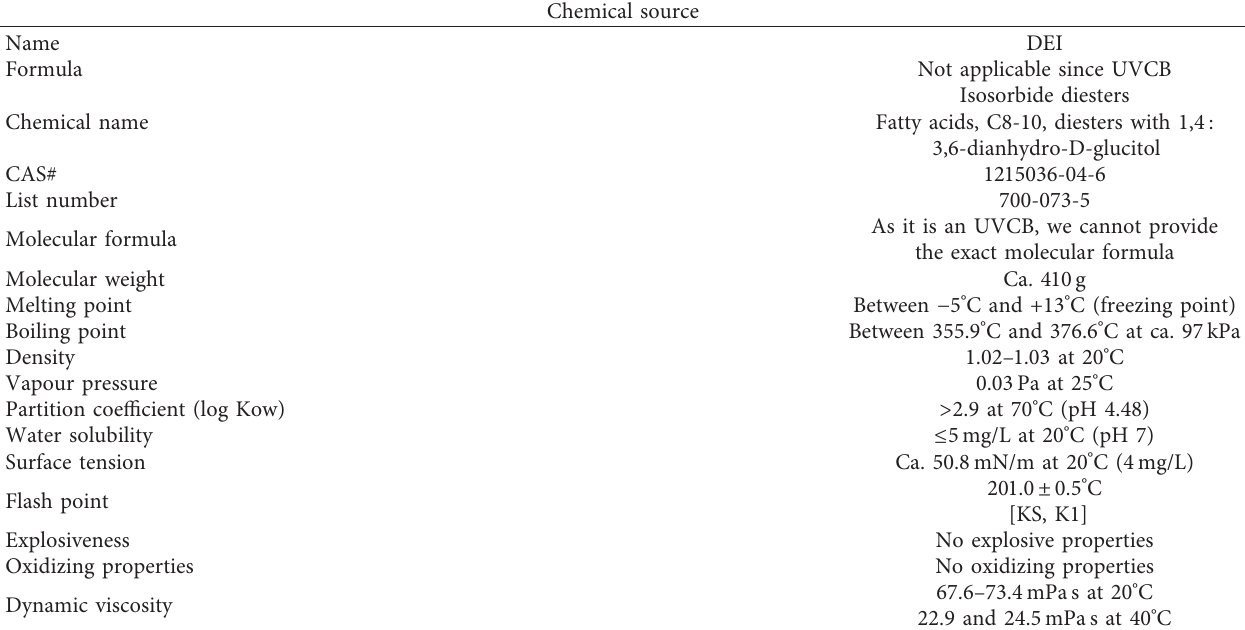
Table 1: Characteristics and properties of POLYSORB ® ID